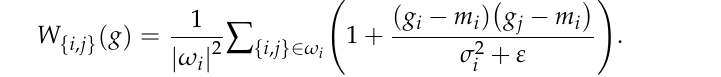
Figure 5. Experimental results of several methods in the brighter areas of the image. ( a ) Original image; ( b ) BIMEF; ( c ) LIME; ( d ) LECARM; ( e ) SDD. To solve the above problems, we designed the BEF function in two directions, as de- tailed in Section 3.2.1. The adaptive contrast enhancement (ACE) method improves the contrast by combining the high-frequency information of the image, but the high-fre- quency component is often doped with noise. Therefore, we devised a form of piecewise function to improve the image contrast pixel by pixel, as detailed in Section 3.2.2. The design of the fusion weight and Gaussian Laplacian pyramid are explained in Section 3.2.3 and Section 3.2.4, respectively. 3.2.1. Brightness Enhancement of Illuminance Map This section designs the BEF function by analyzing several brightness enhancement functions given in Section 2.2. Figure 6 shows two graphs for the different transformation functions, and the values of Equations (2) and (4) at any point are higher than the identity line, indicating that the pixel value at any point of the enhanced image is higher than that of the original image.